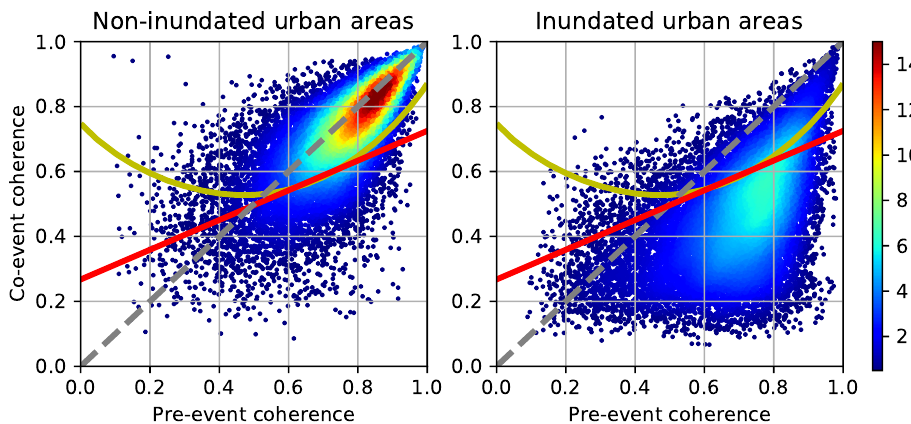
Figure 3. Feature samples of non-flooded and flooded classes collected during the 2018 western Japan floods at the city of Mabi, Okayama Prefecture. The color marks depicts the density samples. The red and yellow solid lines denote the linear and non-linear discriminant functions calibrated using the SVM algorithm, respectively. The dashed line denotes the identity